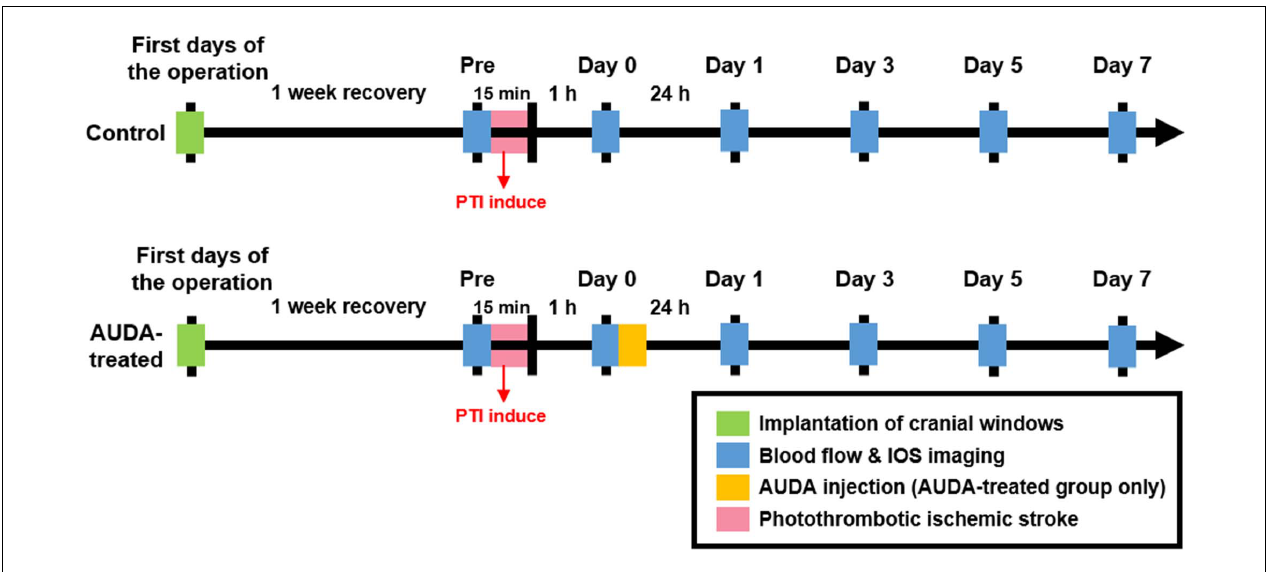
FIGURE 3 | Experimental timeline for monitoring the effect of AUDA after PTI stroke. To monitor the effect of AUDA, ischemic stroke was induced by PTI in both groups for 15 min (red bar). After 1 h from PTI stroke, the rats in the AUDA-treated group received a single AUDA injection (yellow bar). After 1-week of recovery from the cranial window implantation operation (green bar), the images for LSCI and OISI analysis were recorded pre-PTI stroke and post-PTI stroke for 7 days (blue bar) in both